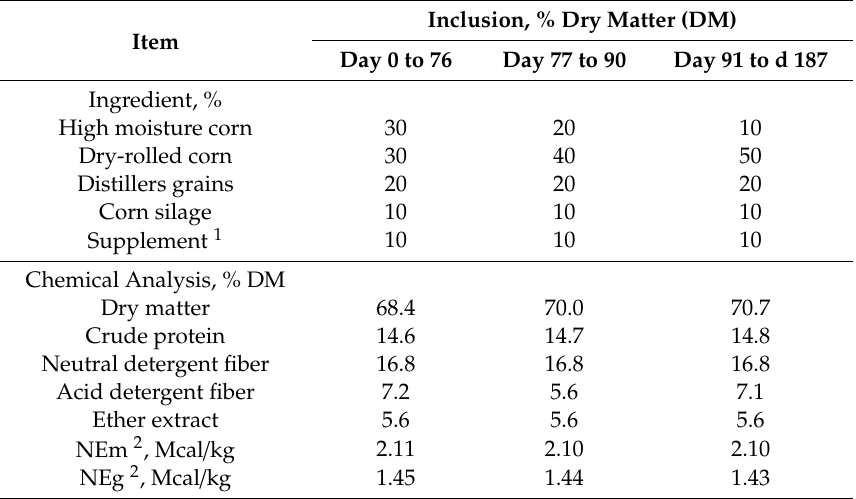
Table 1. Diet and nutrient composition during fishing